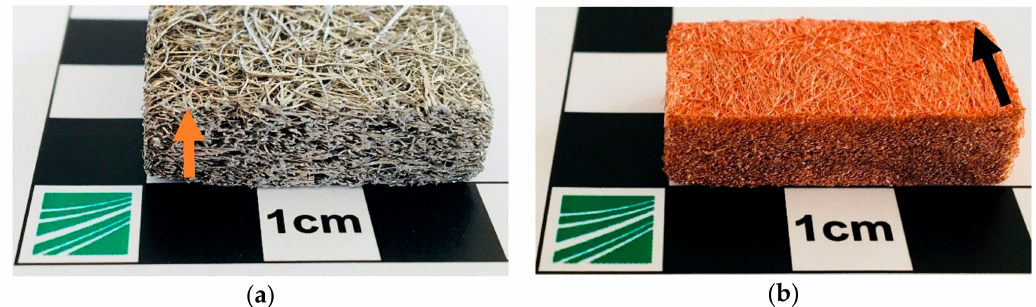
Figure 4. Photography of ( a ) AlSi1 short-fiber structure made from short metal fibers and ( b ) photography of copper long-fiber structure made from endless copper fibers. Arrows indicate the normal vector of the isotropic